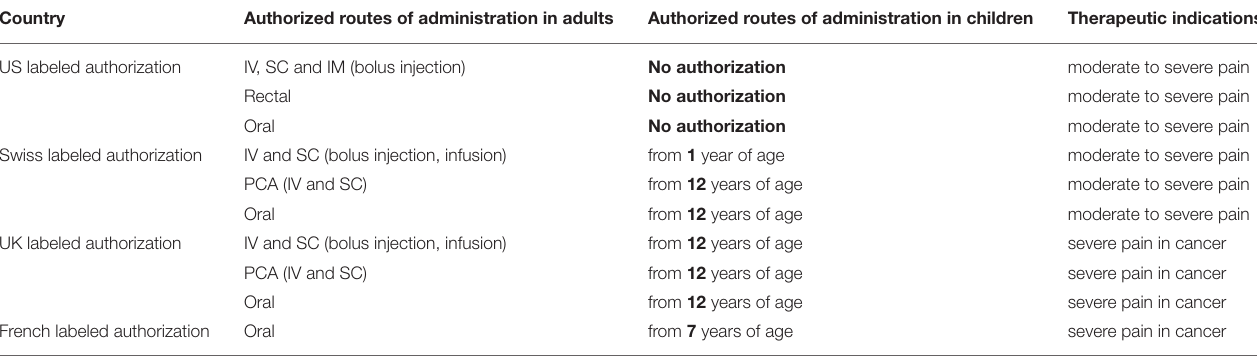
TABLE 2 | Labeled authorization (non-exhaustive list).